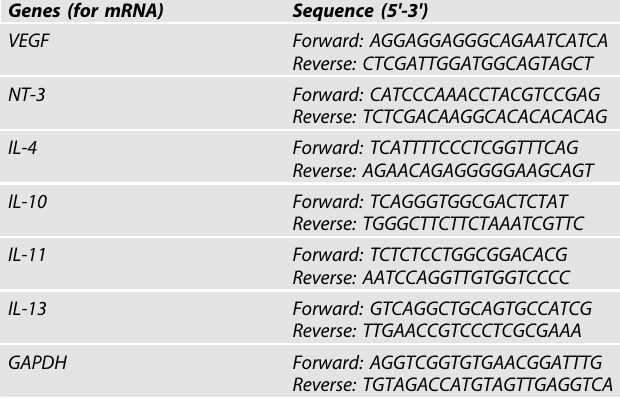
Note: BDNF brain-derived neurotrophic factor, VEGF, vascular endothelial growth factor, NT-3 neurotrophin-3, IL interleukin, GAPDH glyceraldehyde- 3-phosphate